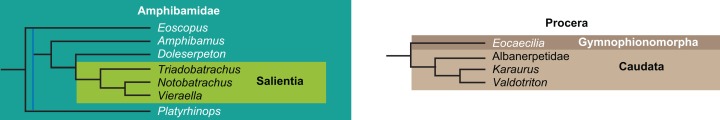
Representation of all MPTs (length: 2,194 steps) from Analysis R3, performed on our revised matrix.Only the parts different from the results of R1 (Figs. 10 and 11) are shown. Outside the shown clades, the entire range of resolutions of R1 also occurs in R3. Procera lies in the place where Lissamphibia is found in R1. The taxon sample was unchanged from RC07. A constraint forced the dissorophoid temnospondyl Doleserpeton to be closer to the three salientians (Triadobatrachus, Notobatrachus, Vieraella) than the lysorophian “lepospondyl” Brachydectes, and additionally forced the gymnophionomorph Eocaecilia to be closer to Brachydectes than to Doleserpeton; this allowed only the PH.